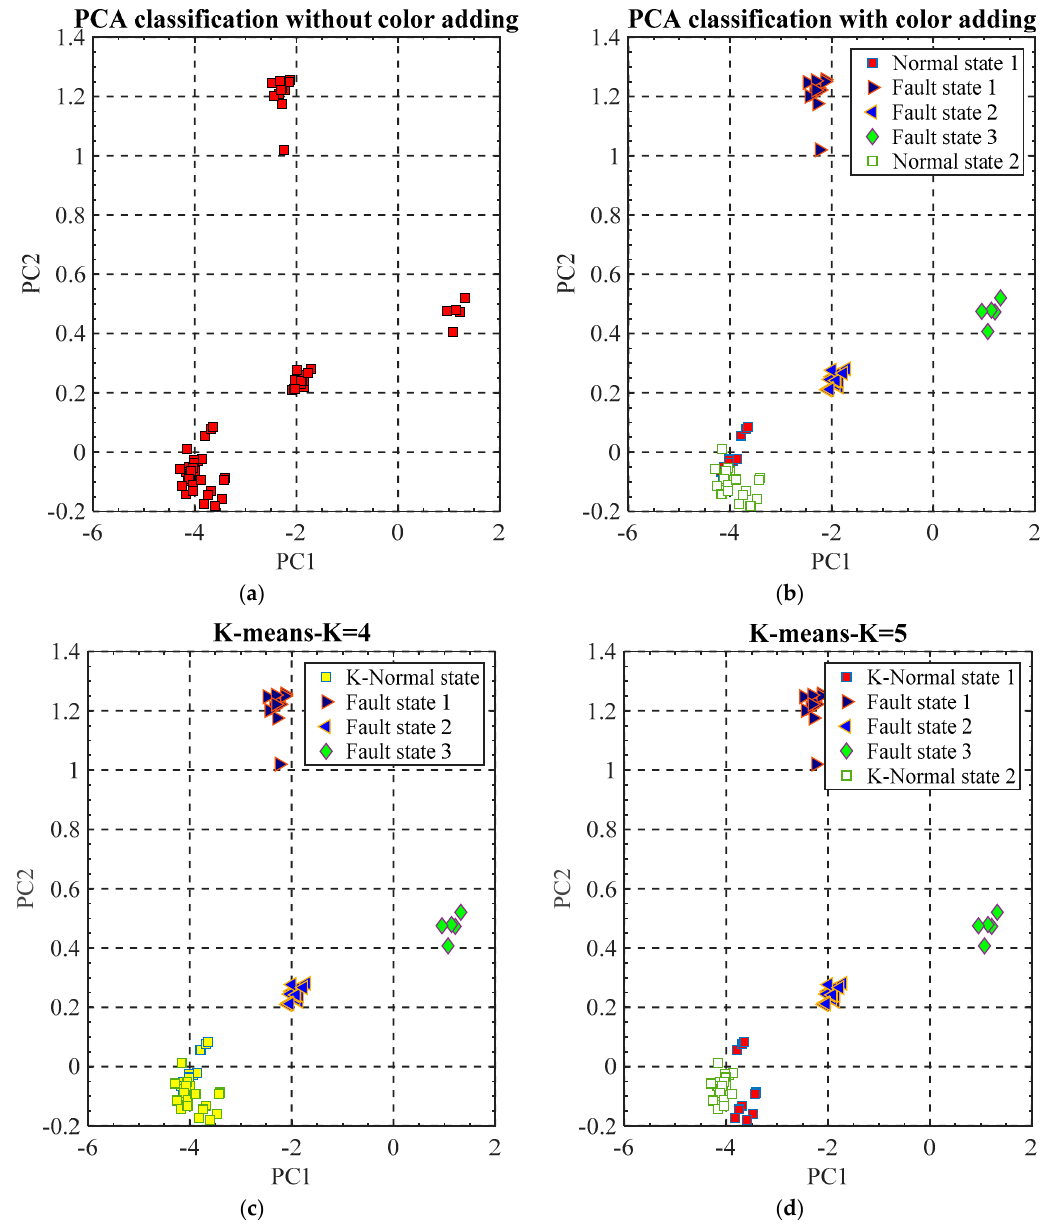
Figure 10. Classification results of VE features with the K-means and PCA method, ( a ) Original PCA classification results; ( b ) PCA classification results with manual color adding to separate the machine tool states; ( c ) K-means classification results with K = 4; ( d ) K-means classification results with K = 5.